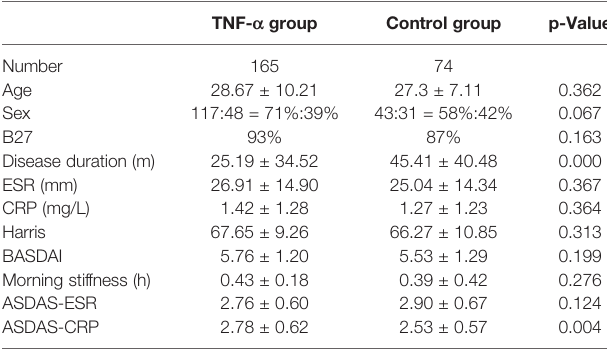
TABLE 1 | Clinical characteristics including disease activity indexes and hip function in both groups at